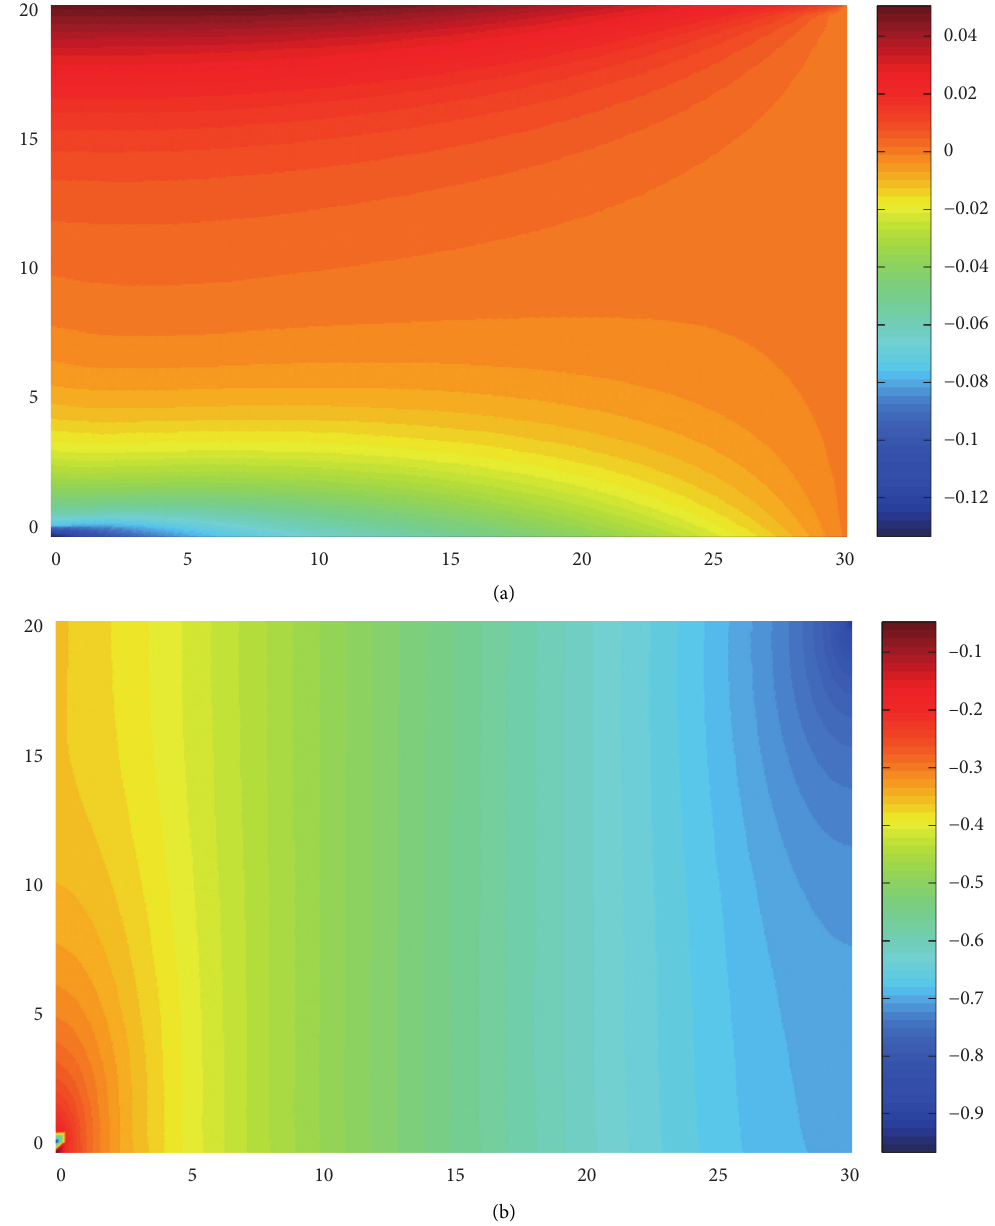
Figure 7: Displacement fields of speckle images using DIC: (a) u